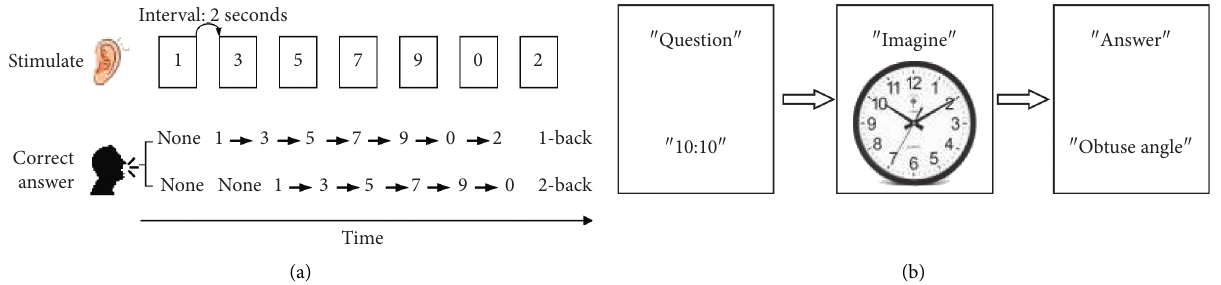
Figure 3: Illustration of the cognitive secondary tasks. (a) N-back task. (b) Clock task.